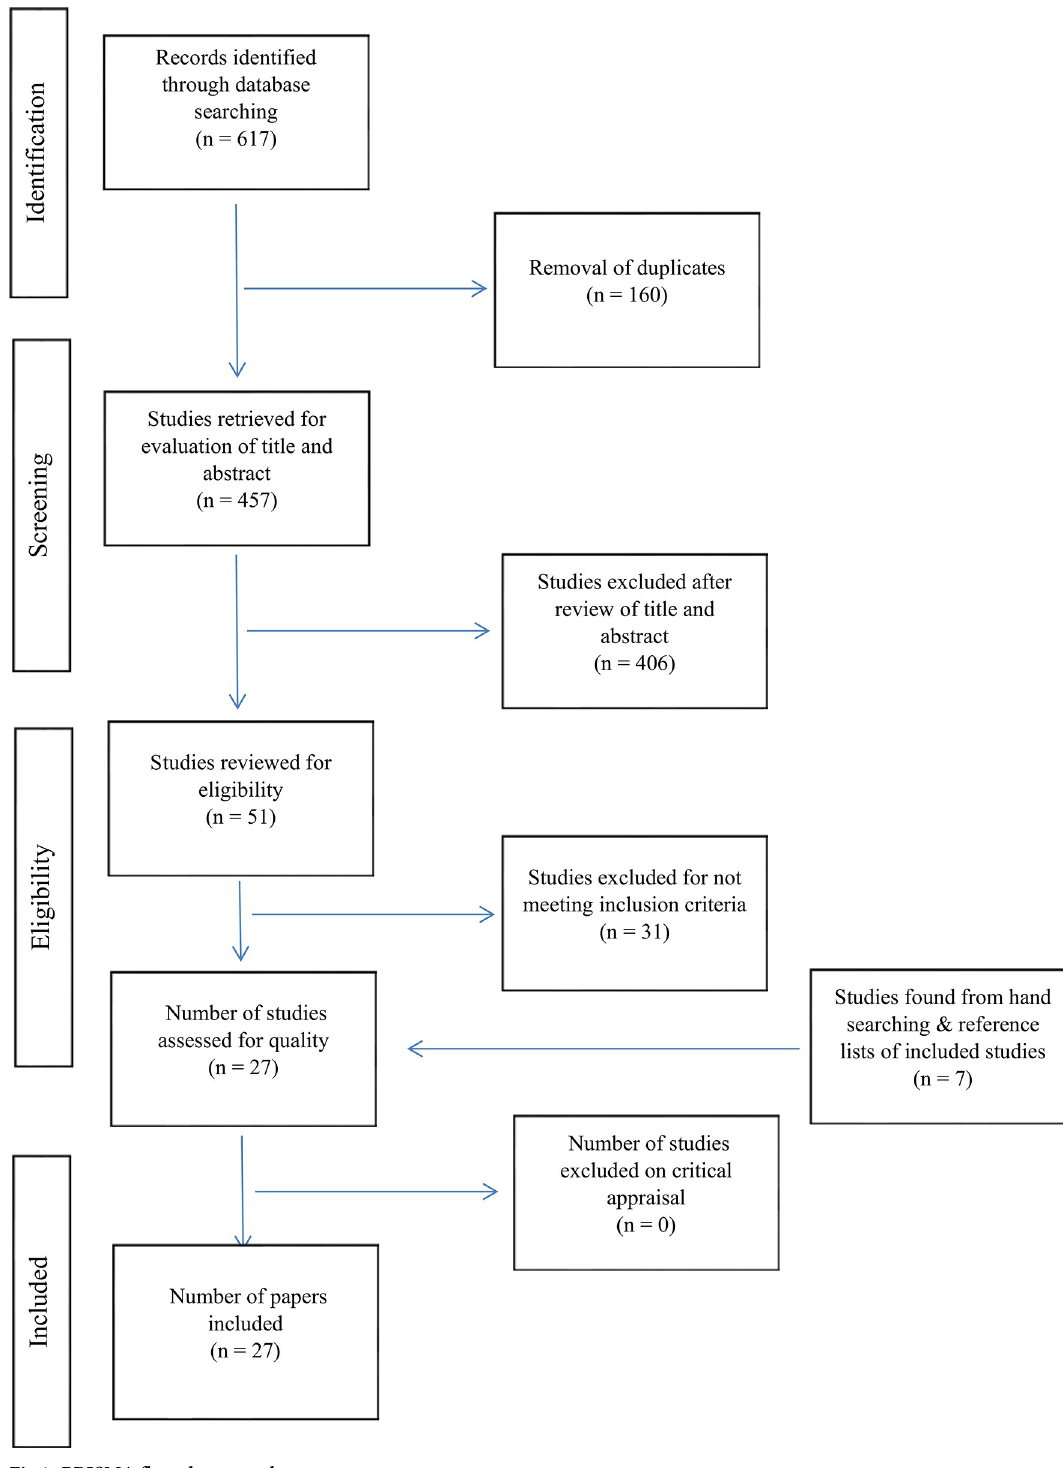
Fig 1. PRISMA flow chart search